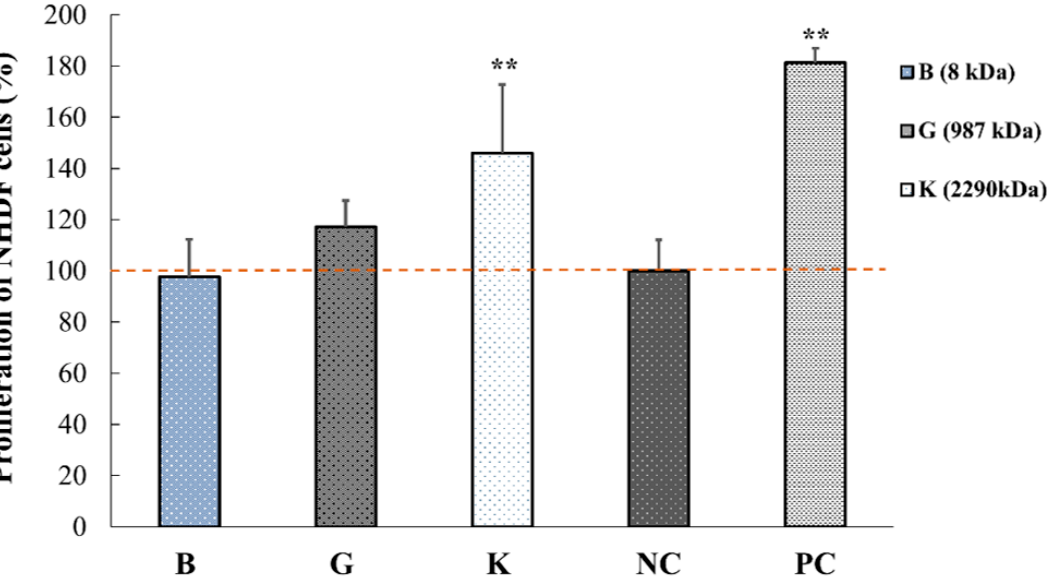
Figure 3. In vitro effect of three different MWs of HA on the proliferation of normal human dermal fibroblasts (NHDF). Control groups include negative control (NC group, 1% FBS-DMEM) and positive control (PC group, 10% FBS-DMEM). Data are expressed as percentage of number of cells (mean ± SEM) vs. NC group ( n = 5, ** p < 0.01).